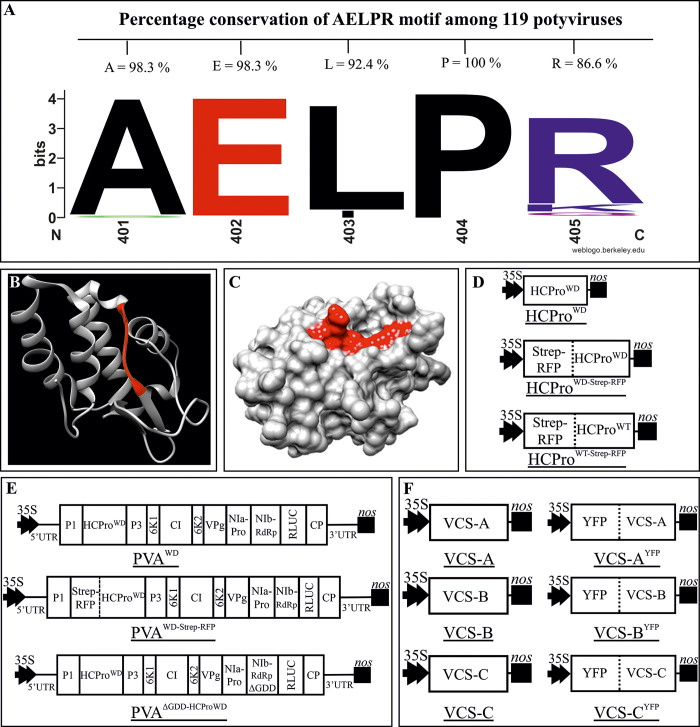
AELRP sequence in HCPro is predicted to bind to proteins containing a WD40-domain.(A) Percentage of amino acid conservation within the AELPR motif in 119 potyviral HCPro sequences. This motif was identified by scanning the PVA HCPro sequence for short linear motifs (SLiMs) via ELM server (http://elm.eu.org/). The AELPR motif was predicted to be a putative WD40 -domain-interacting motif. (B) Ribbon diagram of X-ray crystallographic structure of the cysteine protease domain of TuMV HCPro (PDB ID: 3RNV). Secondary structure of the ‘AELPR’ motif has been highlighted in red. (C) Surface diagram of 3RNV showing the accessibility of the WD40-domain -interacting motif in HCPro (highlighted in red). (D—F) Schematic representation of the constructs prepared for this study (not in scale): (D) HCPro overexpression constructs. (E) icDNAs of the full length PVA constructs. (F) VCS overexpression constructs.